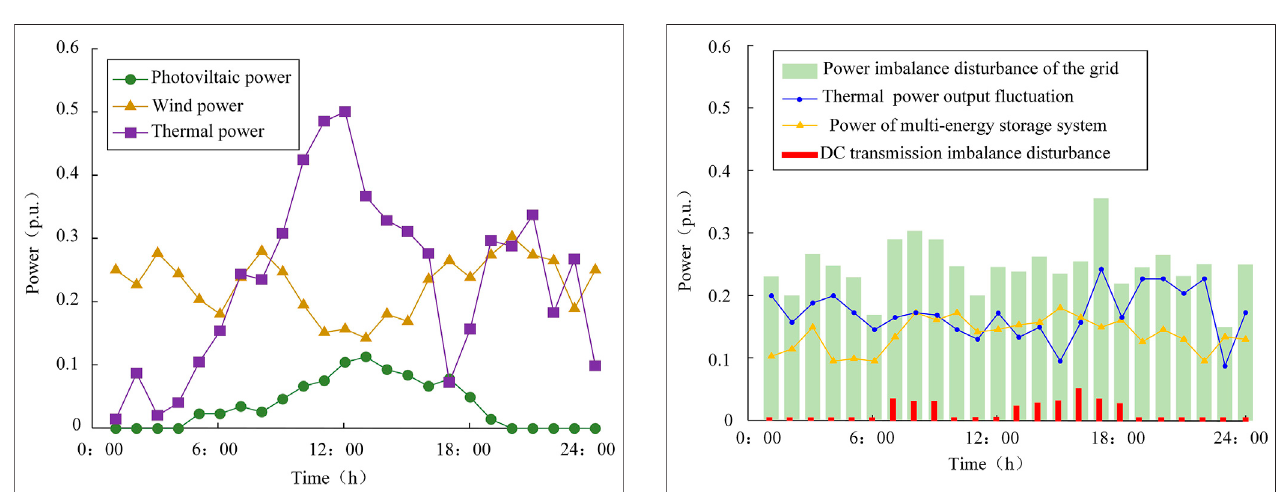
FIGURE 6 | Grid power adjustment curve with multi-energy storage.